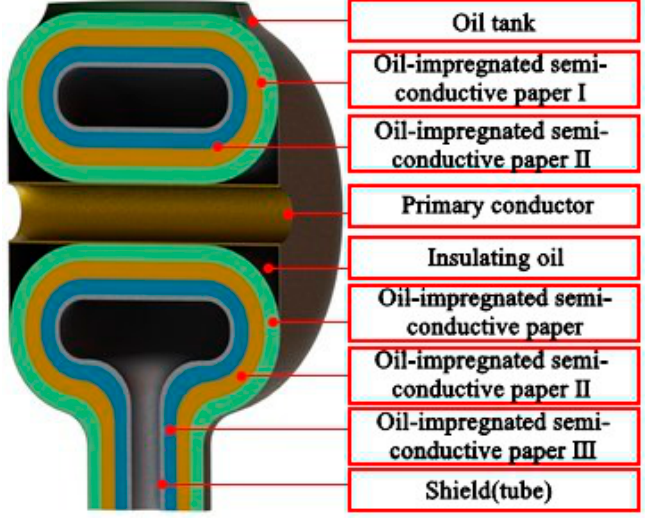
Figure 1. The sectional view of IOCT ring structure.